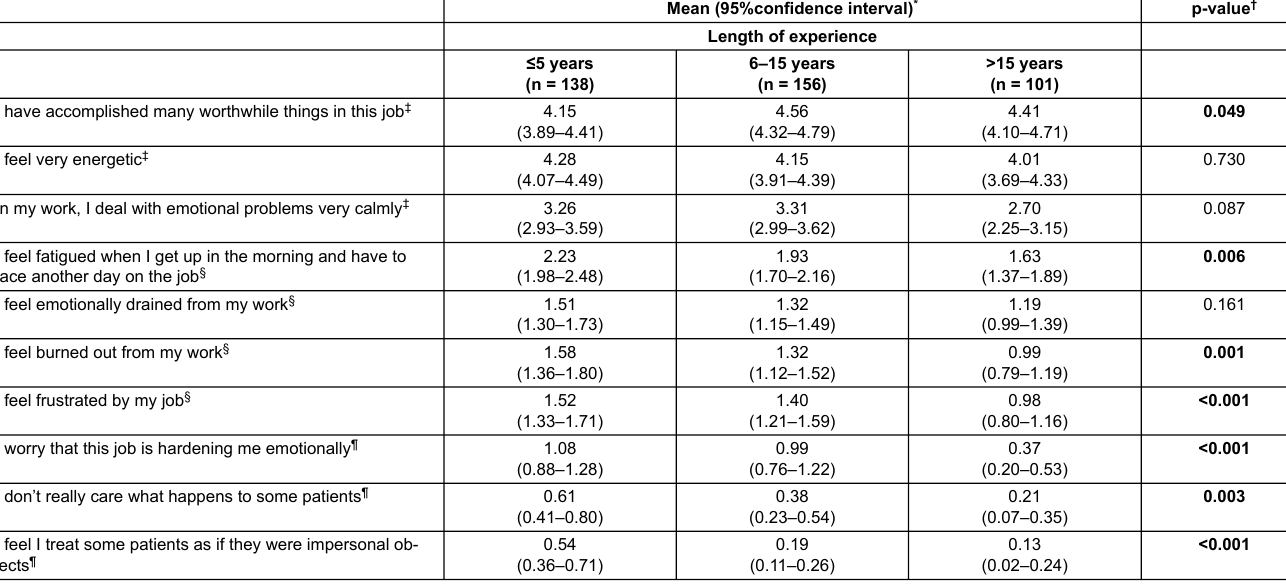
Table 2: Selected questions from the Maslach Burnout Inventory: by length of work experience.